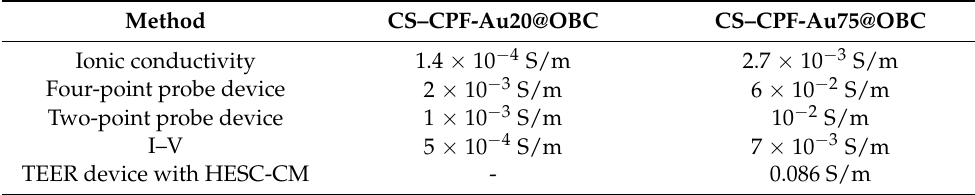
Table 2. The conductivity of thermosensitive and electroconductive hydrogels.